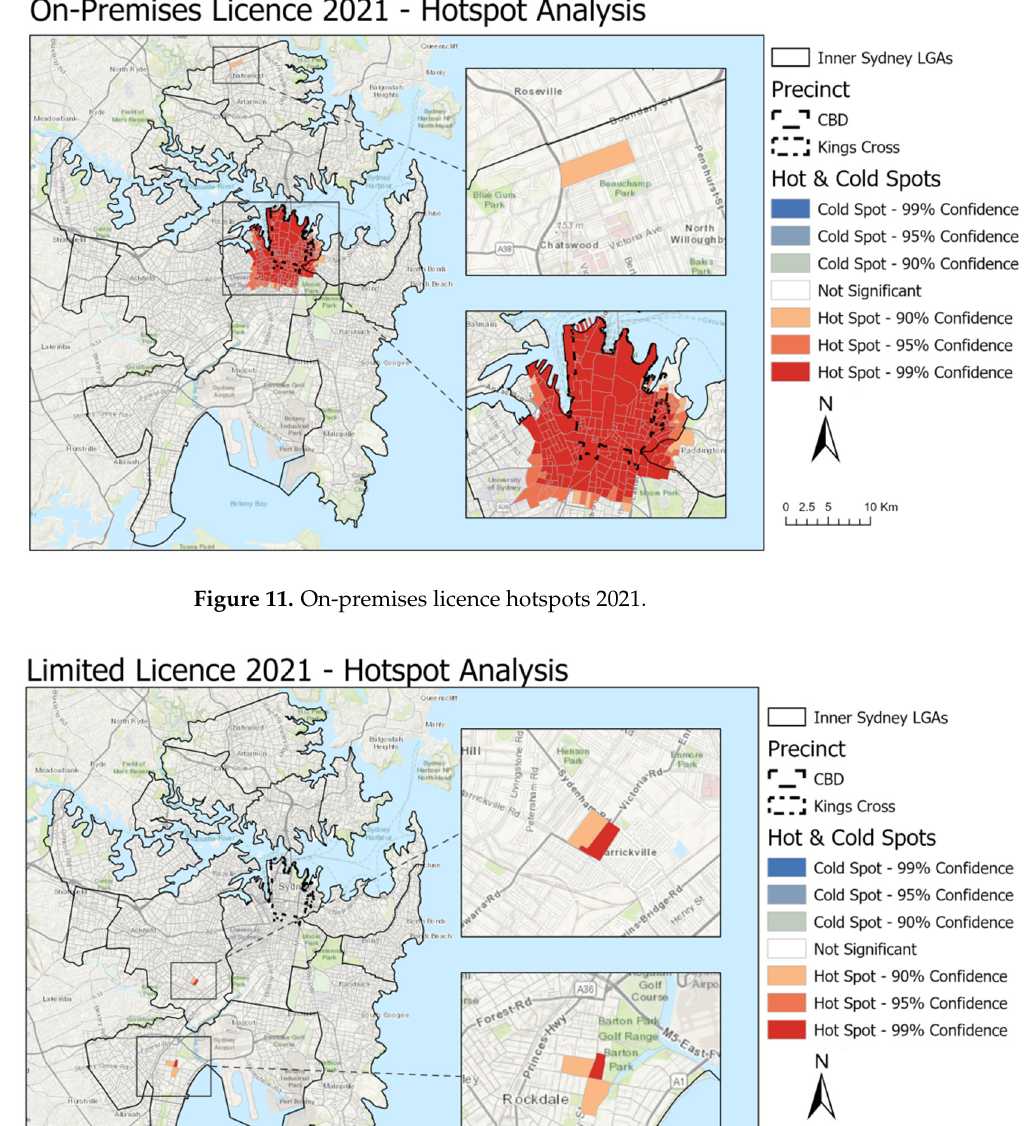
Figure 10. Small bar licence hotspots 2021.